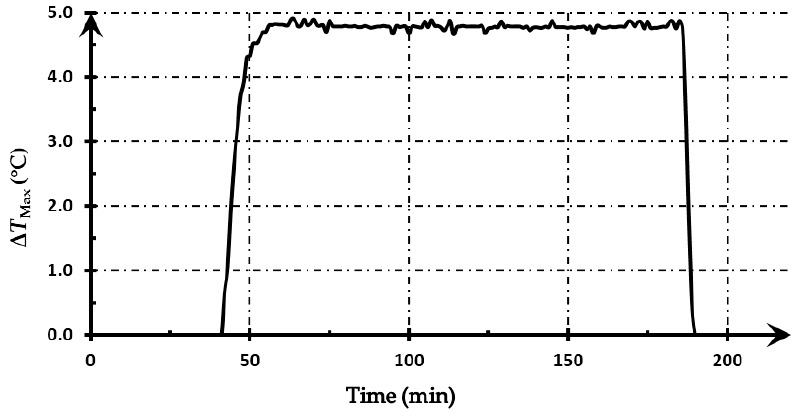
Figure 5. The course of changes of maximum temperature increment Δ T Max on the surface of the observed sample during the test.